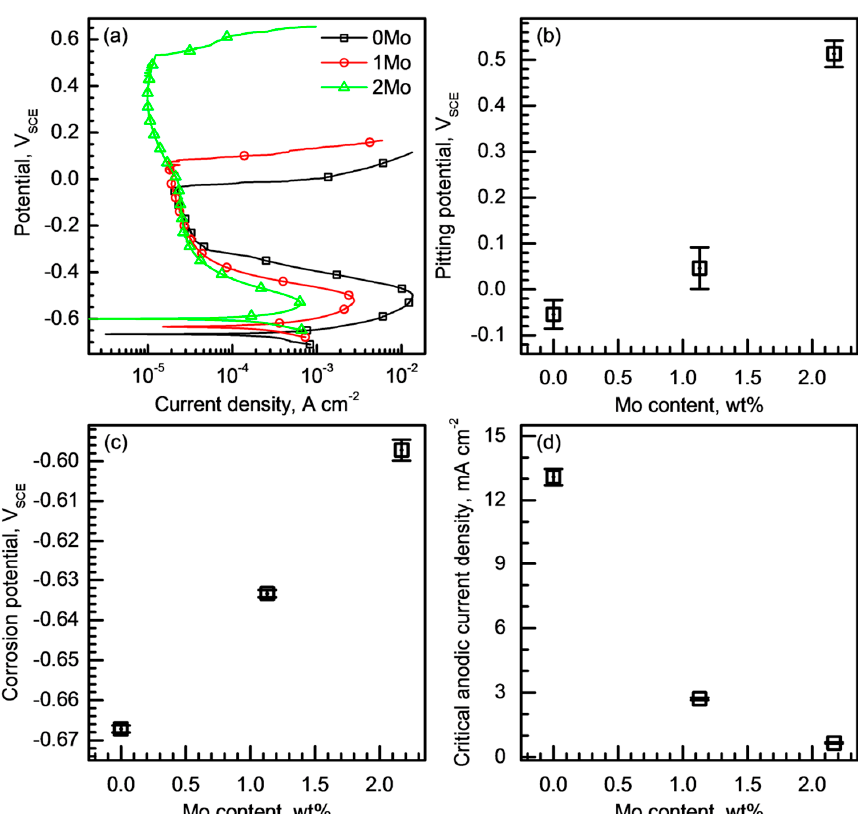
Figure 7. ( a ) Potentiodynamic polarization curves of 0Mo, 1Mo, and 2Mo alloys measured in a 4 M NaCl + 0.01 M HCl solution at 25 °C (d V /d t = 1 mV/s). Average ( b ) pitting and ( c ) corrosion potentials, NaCl + 0.01 M HCl solution at 25 ◦ C (d V /d t = 1 mV/s). Average ( b ) pitting and ( c ) corrosion